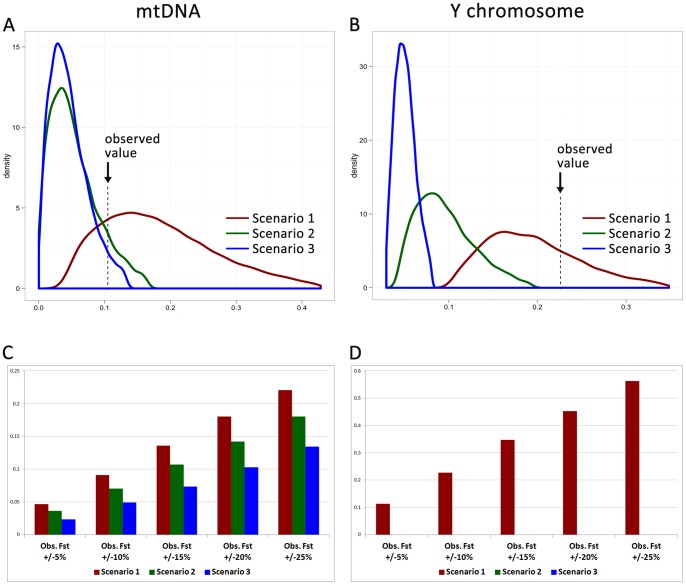
Posterior densities of Fst genetic distances for three micro-evolutionary scenarios.Frame A and B show mtDNA and Y chromosome diversity, respectively. Frames C and D show the proportion of mtDNA and Y chromosome simulations, respectively, with Fst values falling within different ranges around the observed Fst values (5%, 10%, 15%, 20%, and 25%, from left to right).